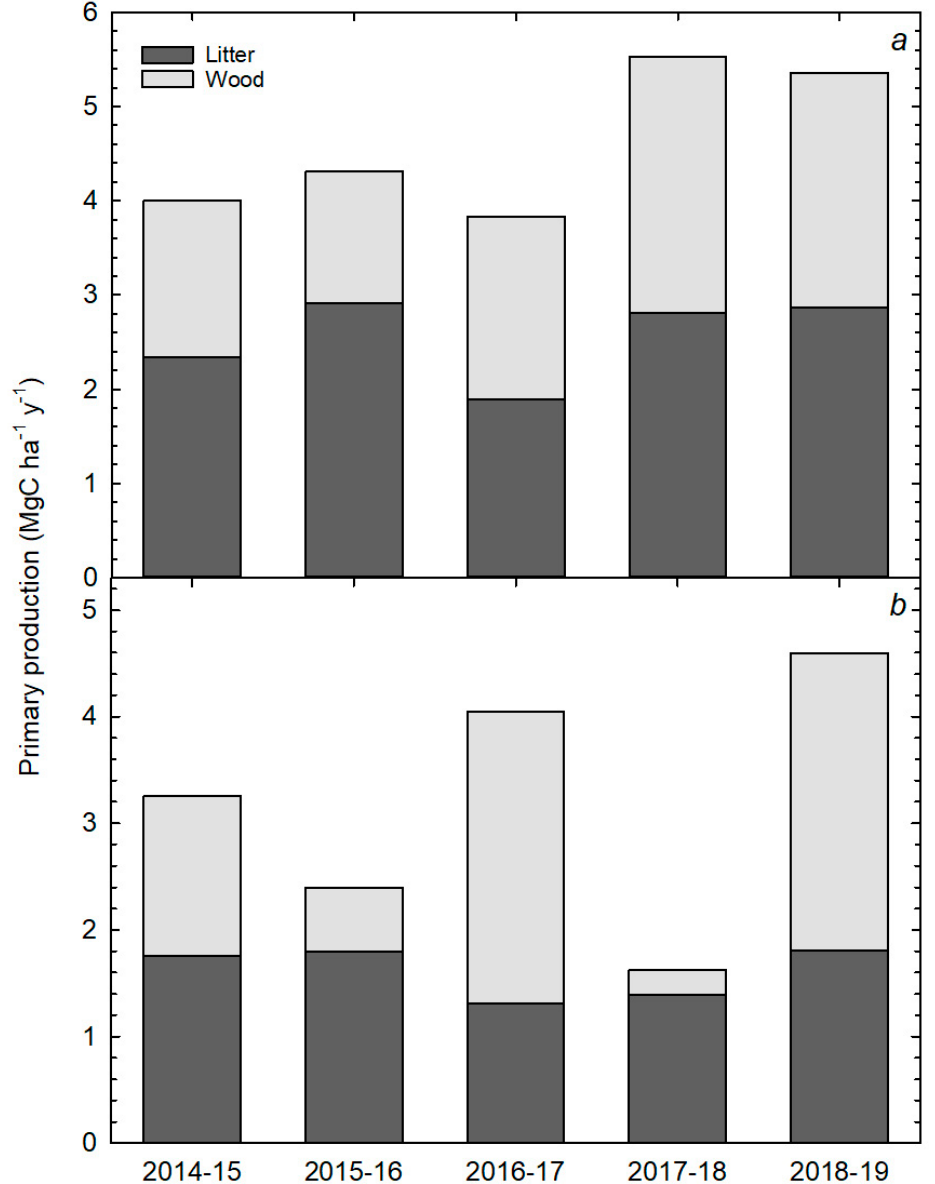
Figure 5. Mean aboveground primary production from litter (dark gray) and wood (light gray) for each year of the study period in the seasonally flooded cerrado forest ( a ) and the upland mixed forest ( b ).